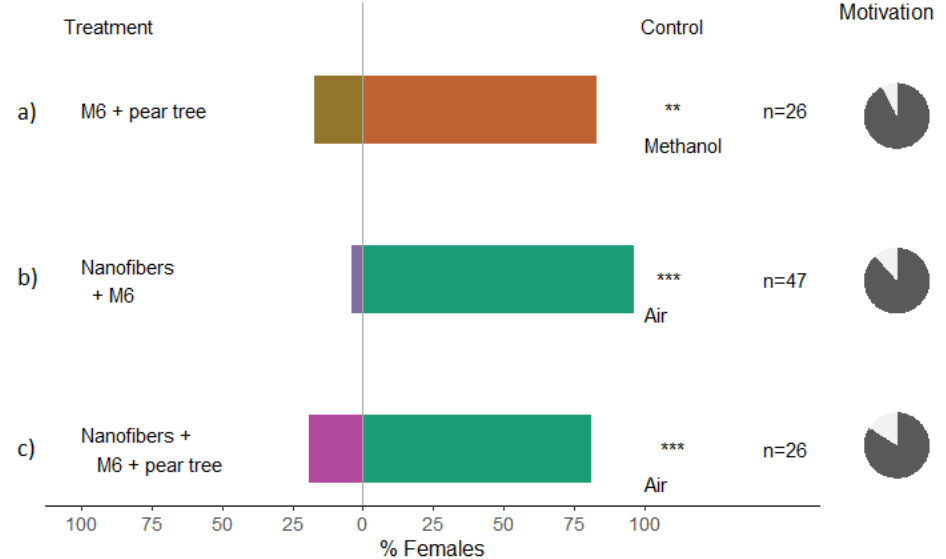
Figure 3. Results of Y-olfactometer-bioassays testing synthetic clove VOCs dissolved in methanol with adults of Cacopsylla pyri . Pure methanol was used as control. The letter “n” corresponds to the numbers of insects used for the tests. Results are shown as the percentage of psyllids in each arm. Statistically significant differences are indicated with * ( p < 0.05); ** ( p < 0.01). The percentage of psyllids that made a choice (dark gray) or not (light gray) is presented as pie charts on the right. Insects 2021 , 12 , x FOR PEER REVIEW